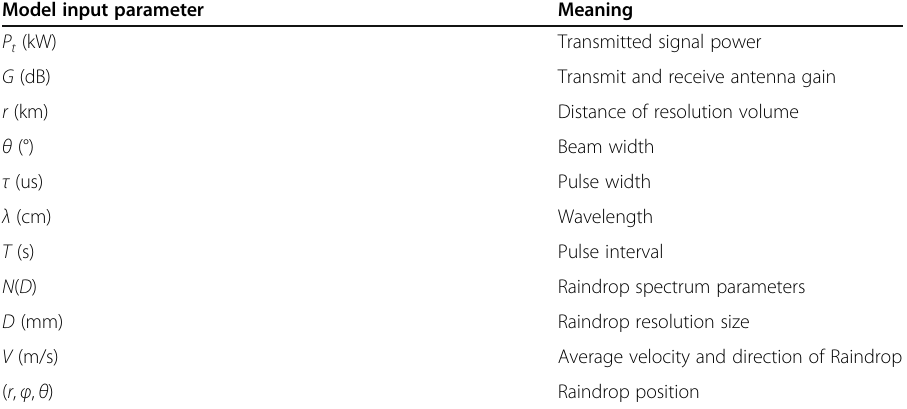
Table 2 Model input